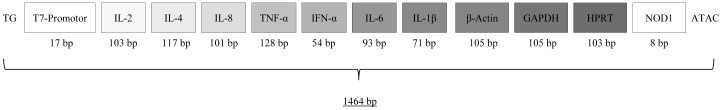
Composition of the synthetic standard gene comprising all target cytokines (IL-2, IL-4, IL-8, TNF-α, IFN-α, IL-6, IL-1β) and internal reference genes (β-Actin, GAPDH, HPRT (Hypoxanthin-Guanin-Phosphoribosyltransferase), starting with the T7-promotor sequence and concluding with the NOD1 restriction site as initial point for linearization and transformation to RNA.Each target cytokine was included with a nucleotide overhang of approximately 50 base pairs (bp) prior to forward primer sequence. In total, the synthetic standard gene comprises 1464 bp.